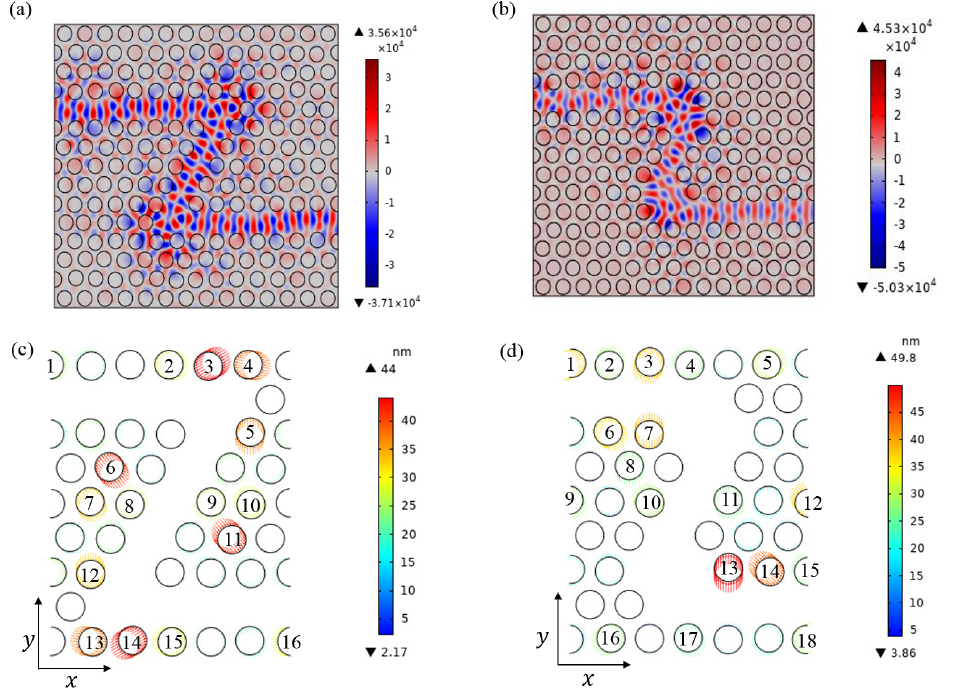
Figure 4. The electric fields in z direction at 1550 nm in the ( a ) straight Z waveguide and the ( b ) curved Z waveguide. The radius of the air hole a = 251 nm, lattice constant l = 2.82 ∗ a . Topology optimization diagram of ( c ) straight Z waveguide and ( d ) curved Z waveguide in the curved part. The arrows on the air holes indicate the direction of movement through topology optimization, and the arrows in different colors indicate the movement distance of the air holes. The numbers on the air holes indicate the air holes with the relative displacement greater than 25 nm. Table 1. The displacement coordinates of the air holes with the relative displacement of the straight Z waveguide greater than 25 nm. Number is the number of the selected air holes. x and y represent the relative displacement of the selected air holes in different